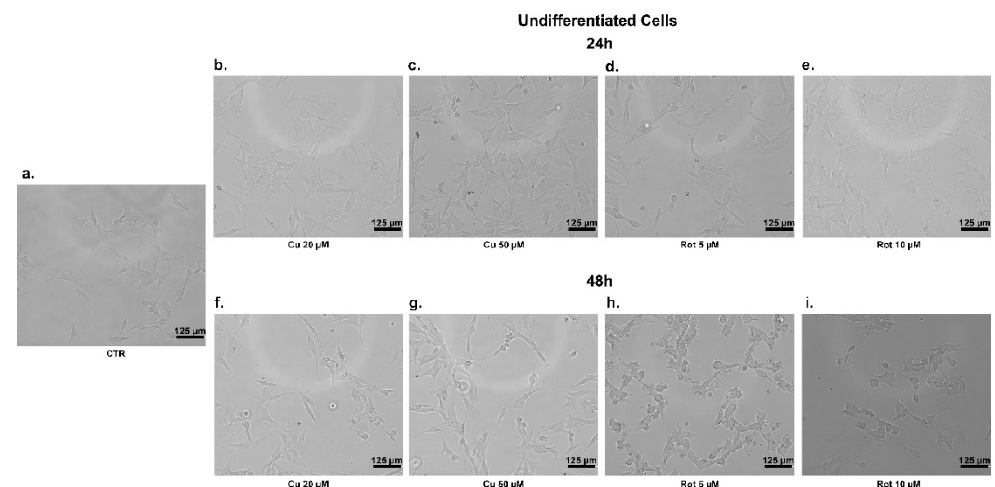
Figure 3. SHSY5Y undifferentiated cells treatments. Phase contrast images of cellular morphology of SHSY5Y undifferen- tiated cells after copper ( b , c , f , g ) and rotenone ( d , e , h , i ) treatments for 24 and 48 h. The morphological alteration in cells treated with rotenone for 48 h is noticeable, especially compared with the untreated cells on the left ( a ).